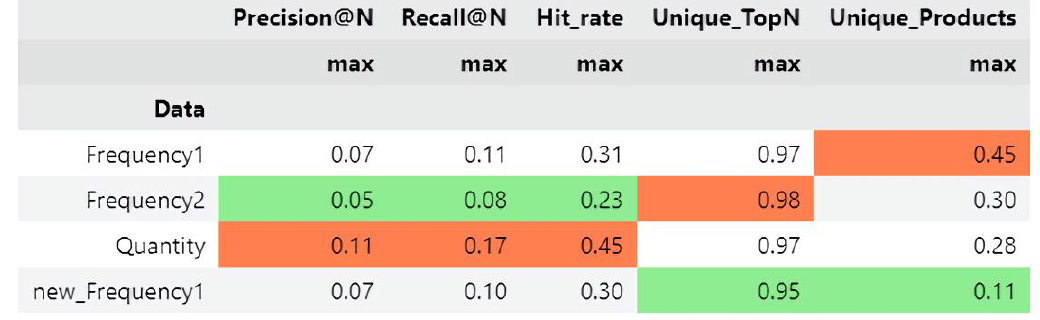
Figure 14. Surprise library best evaluation results